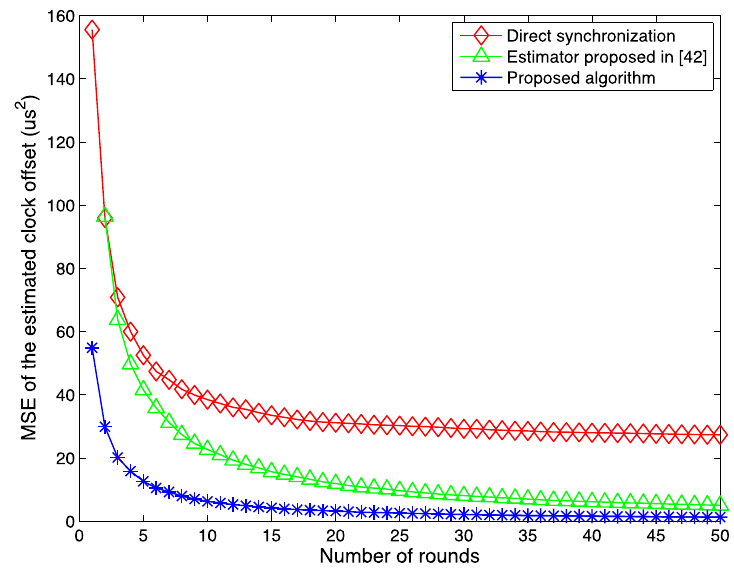
Figure 5. Comparison among the proposed algorithm, direct synchronization, and estimator proposed in [42]; β = 100 μs, μ = 5 μs and λ = 1. 0 Table 1 summarizes the computational complexity of the three estimators. The numbers of the operations for the clock synchronization by the nanomachine or sensor node are shown in the table. The values are calculated based on the expressions of the different estimators. From the figure it is clear that the direct synchronization method uses fewer operations than the other two estimators. But the performance in terms of the accuracy is the worst, which is obtained in Figure 5. The complexity of our proposed algorithm and the estimator proposed in [42] are both O p N q . Table 1. Complexity comparison of different